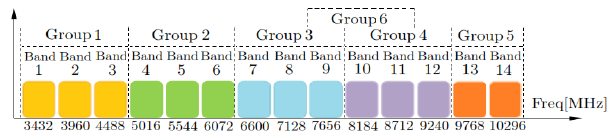
FIGURE 2: The frame structure of The MB - OFDM through the ECMA - 368 standard ECMA - 368 standard.